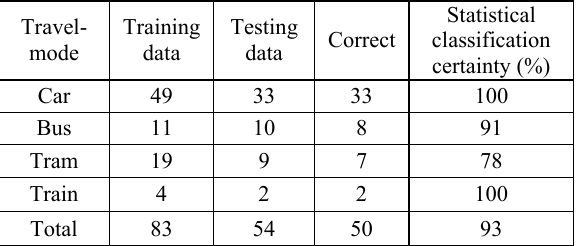
Table 3. Classification results of SVMs classification